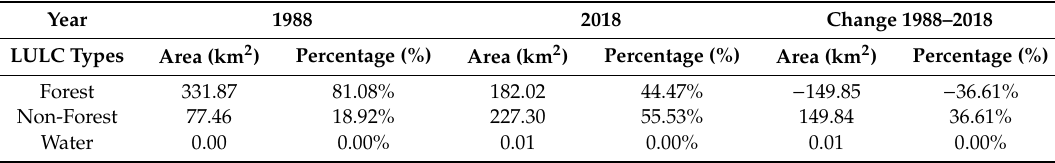
Table 2. Amount of changes in LULC during 1988–2018.